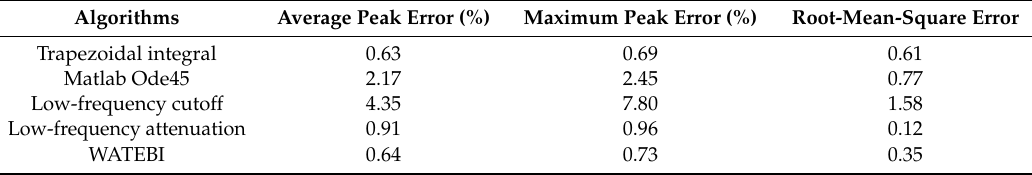
Table 6. Five methods for the displacement reconstruction of Kaikoura